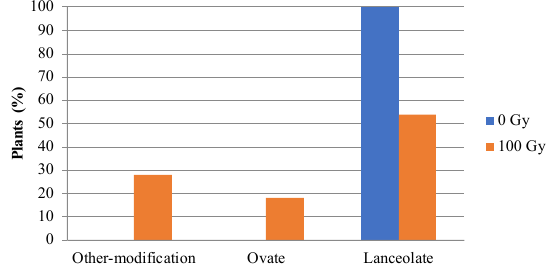
Figure 8. Effects of 100 Gy irradiation on the leaf morphology of the M1 generation of coffee ( Coffea arabica L. var. typica) plants grown under nursery conditions on “Genova Farm,” San Ramon District, Department of Junín,